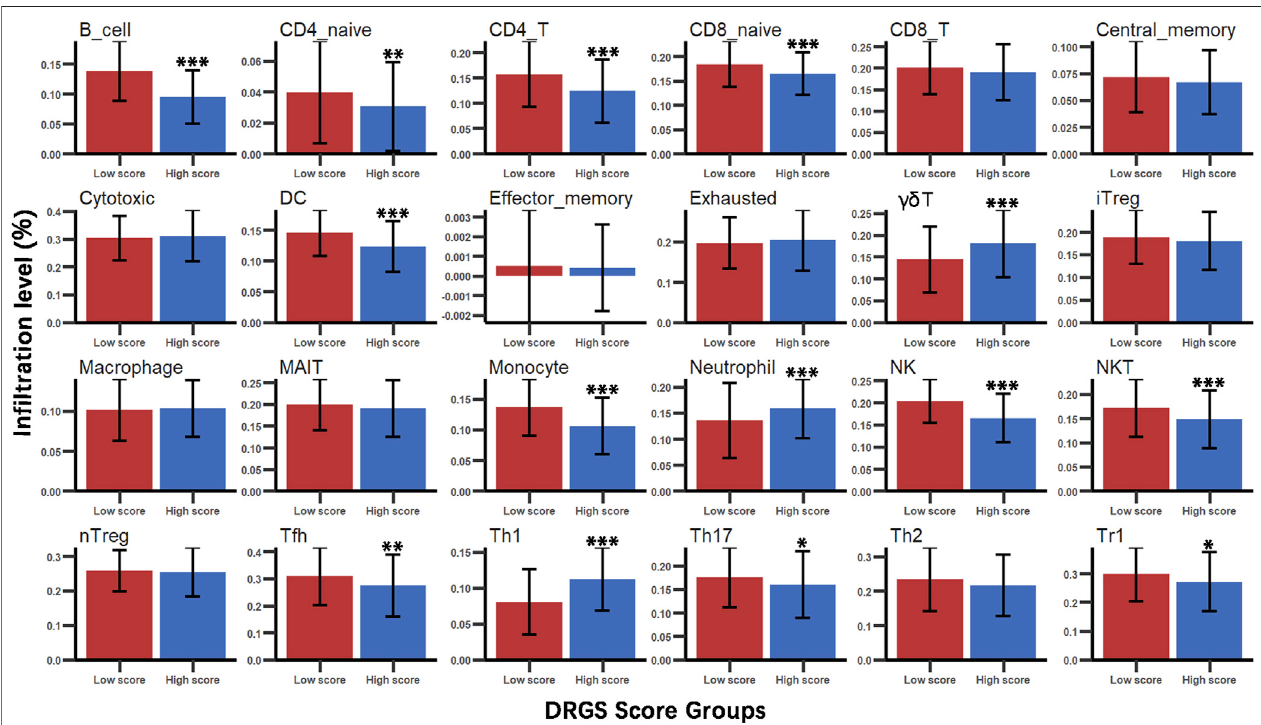
FIGURE2 | Immune cell types in fi ltration in DRGS high ( n = 187) and low ( n = 188) scoresubgroups. Mann WhitneyU test was used to compare the distribution of multiple immune cell in fi ltrations between the two groups (* p < 0.05, ** p < 0.01, *** p < 0.001).